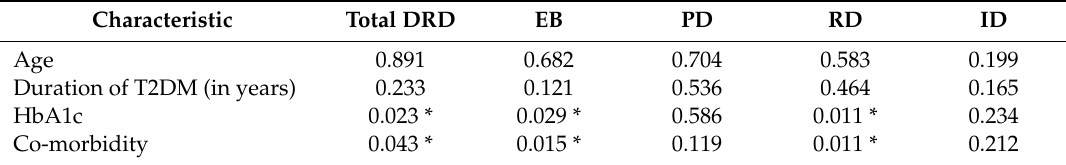
Table 4. Association between diabetes-related distress and potentially related factors (n =